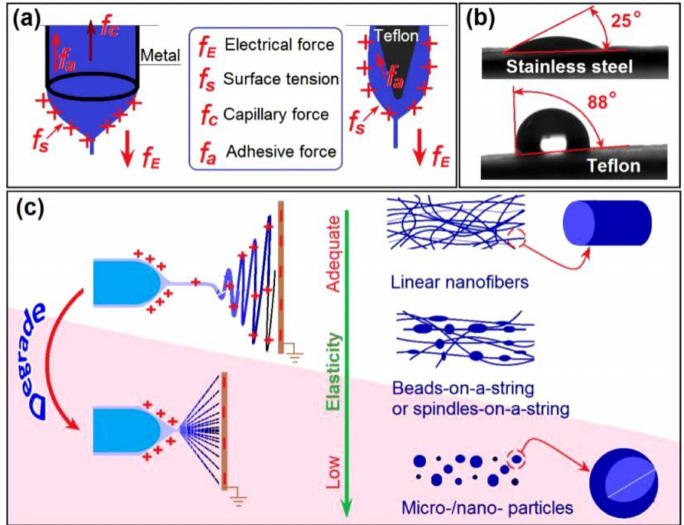
Figure 6. Mechanism of energy saving based on the concentric spinneret with a Teflon-core rod and the micro-formation of nano products. ( a ) Backward forces that waste electrical energy. ( b ) WCA showing adhesive forces between the working fluids on di ff erent surface textures. ( c ) Changes in products as a function of the PVP concentration in the